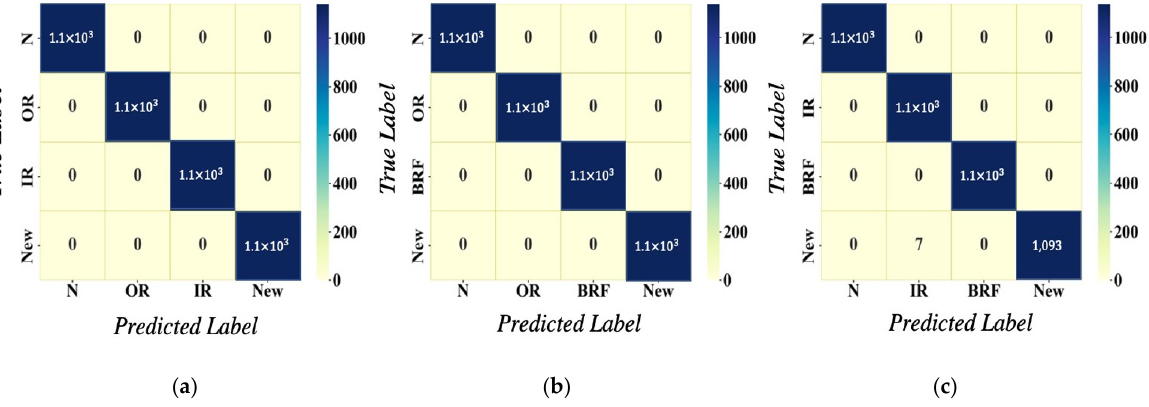
Figure 5. Confusion matrix of feature transferring from Ottawa to CWRU. ( a ) Hidden the labels of BRF faults. ( b ) Hidden the labels of IR faults. ( c ) Hidden the labels of OR faults.